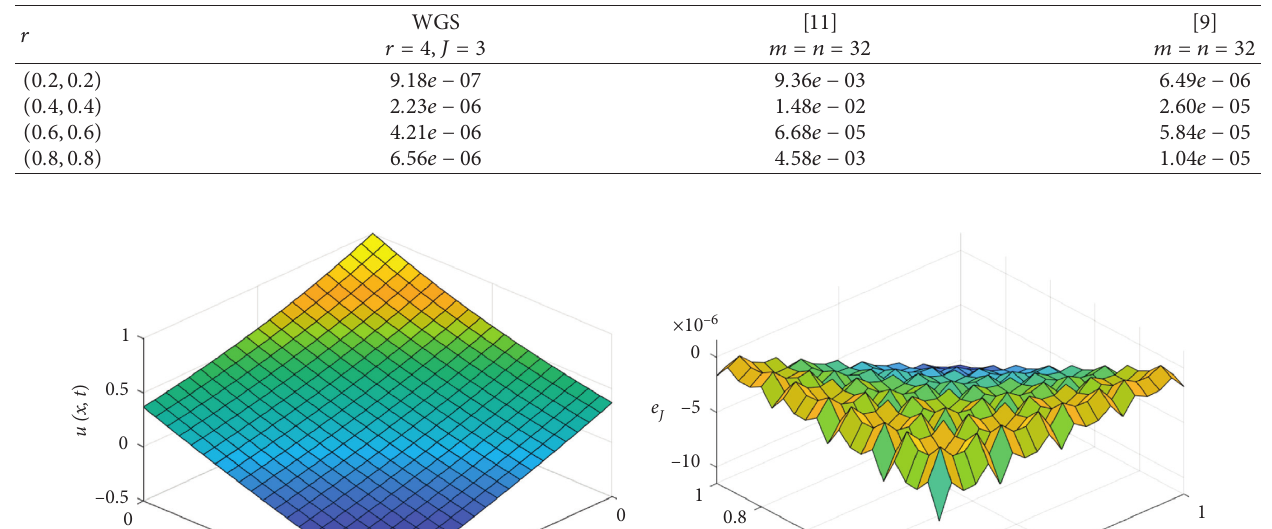
Table 3: Comparison of maximum absolute value errors with others for Example 2.